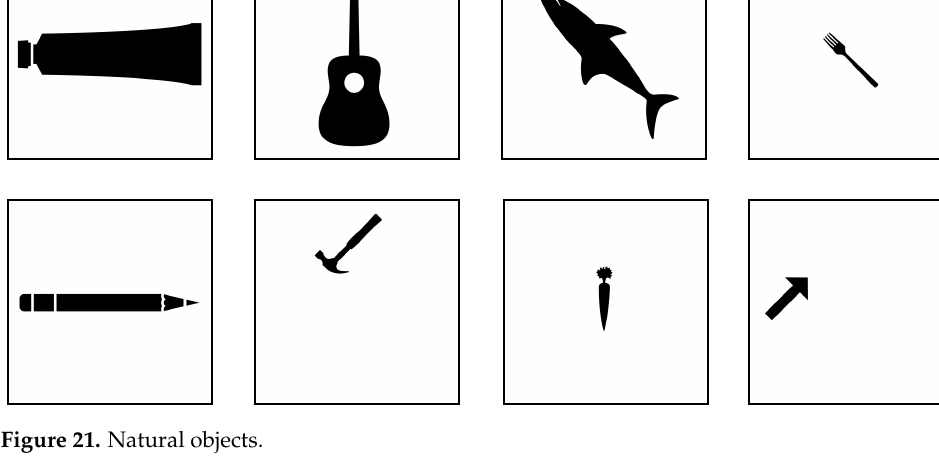
Figure 21. Natural objects.